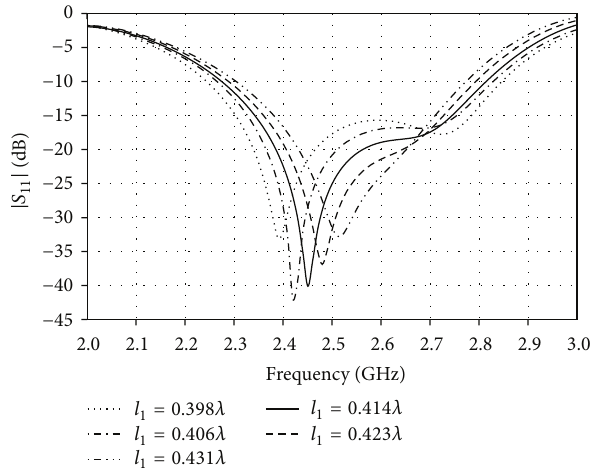
Figure 10: Simulated |𝑆 11 | for various distances between the probe and the closed end of the waveguide ( 𝑙 1 ).